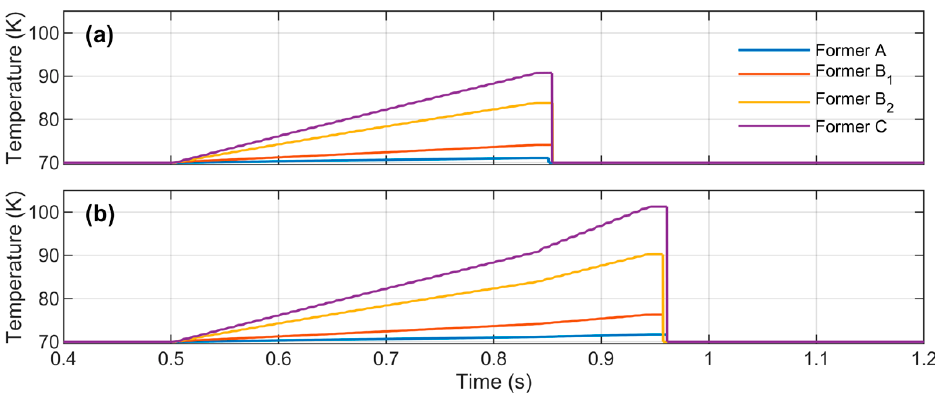
Figure 21. HTS cable resistances in case DCR fails: ( a ) HTS 1 ; ( b ) HTS 2 .